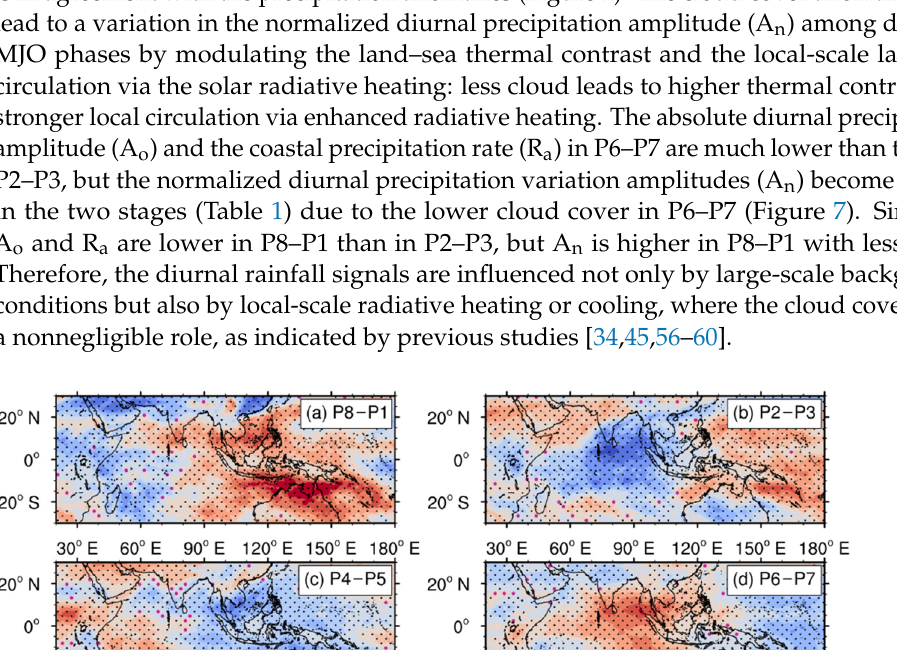
Figure 6. The anomalies of water vapor mixing ratio at 850 hPa (g kg − 1 ) in ( a ) P8–P1, ( b ) P2–P3, ( c ) P4–P5 and ( d ) P6–P7. The black dots indicate the 95% confidence according to the Student’s t-test.